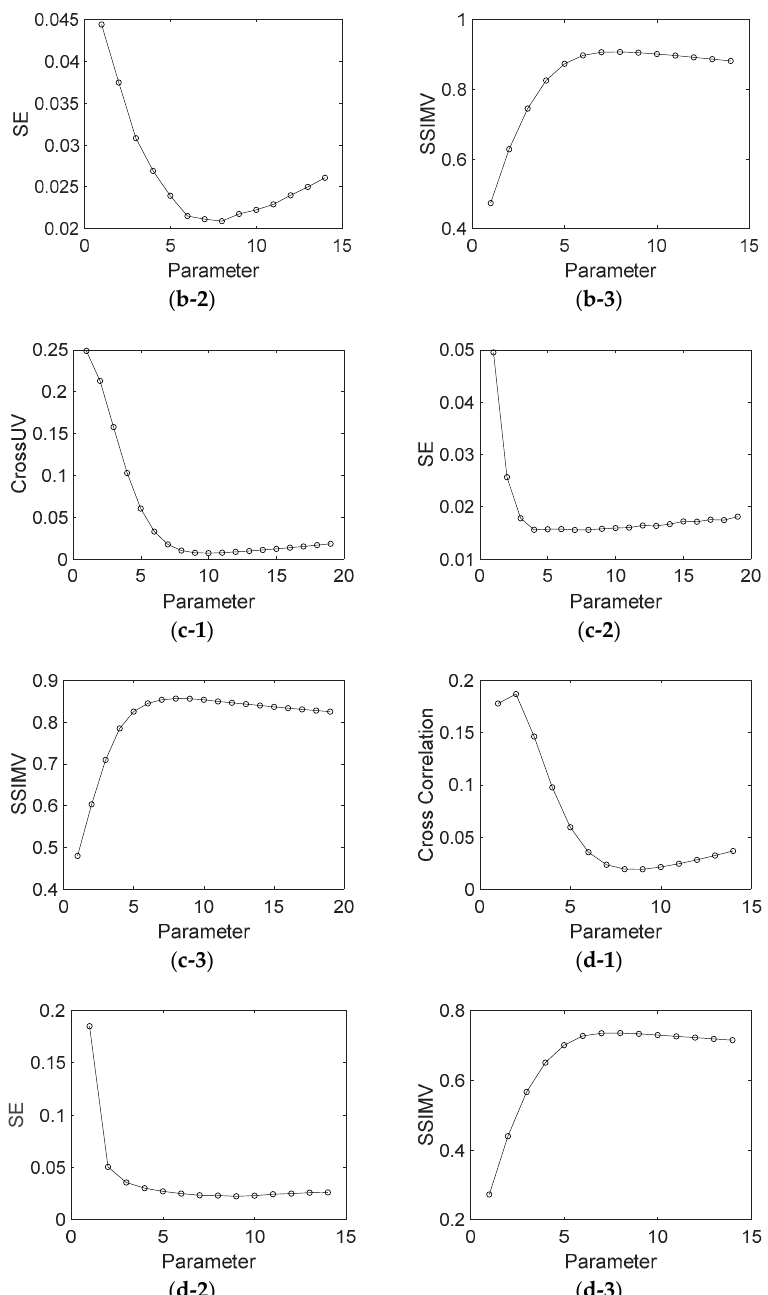
Figure 5. CrossUV, SE and SSIMV for Figure 1 by Fourier transform method with different parameter values. ( a-1 ) CrossUV for Figure 1a; ( a-2 ) SE for Figure 1a; ( a-3 ) SSIMV for Figure 1a; ( b-1 ) CrossUV for Figure 1b; ( b-2 ) SE for Figure 1b; ( b-3 ) SSIMV for Figure 1b. ( c-1 ) CrossUV for Figure 1c; ( c-2 ) SE for Figure 1c; ( c-3 ) SSIMV for Figure 1c; ( d-1 ) CrossUV for Figure 1d; ( d-2 ) SE for Figure 1d; ( d-3 ) SSIMV for Figure 1d.